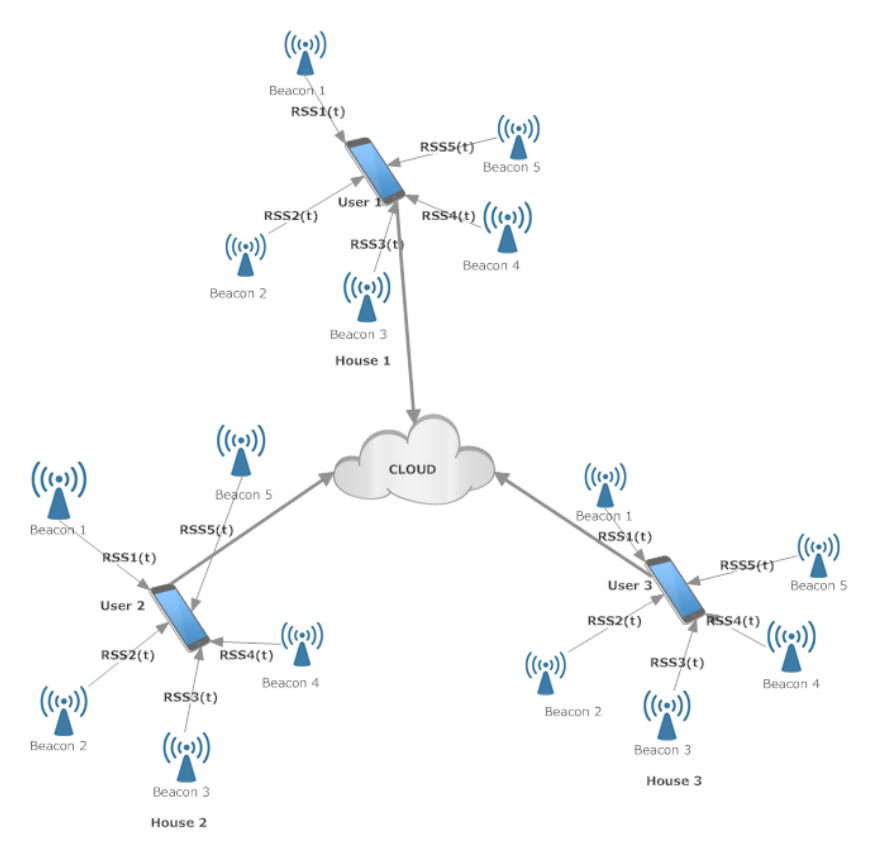
Figure 2. An overview of the system